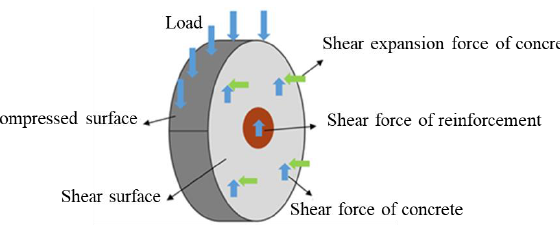
Figure 12. Stress of perforated plate